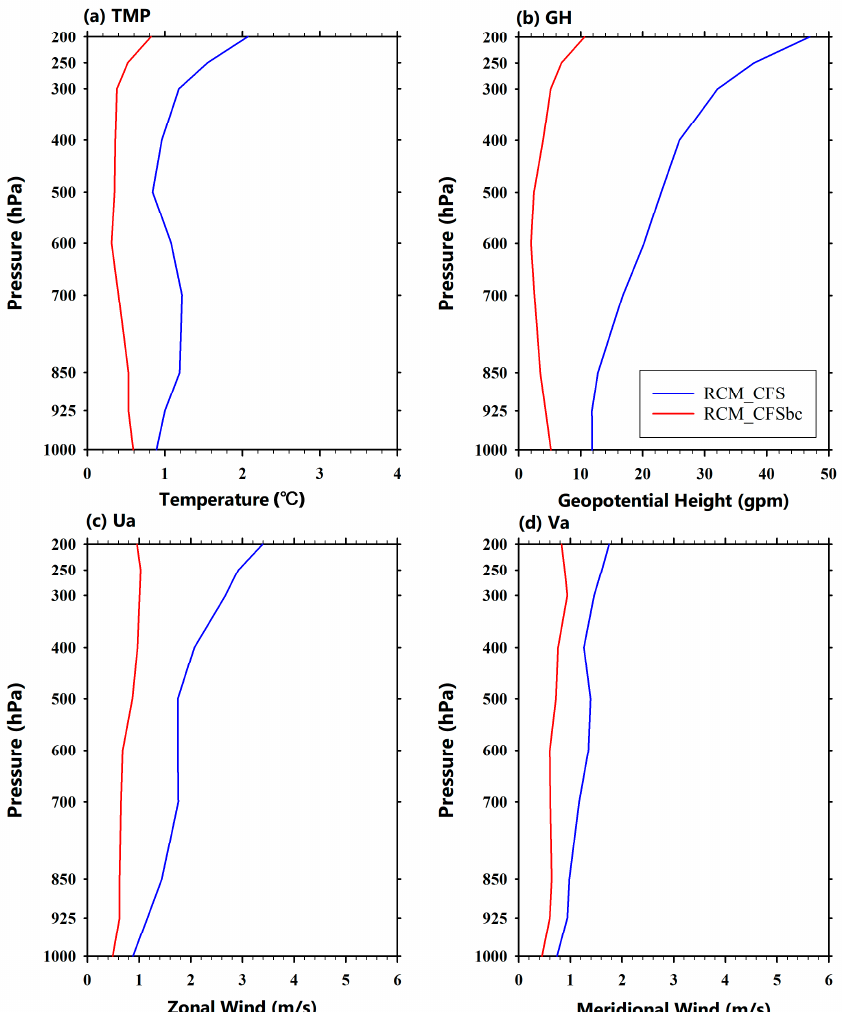
Figure 3. Root mean square difference (RMSD) between RCM_R2 and RCM_CFS (blue line), Figure3. Rootmeansquaredi ff erence(RMSD)betweenRCM_R2andRCM_CFS(blueline), RCM_CFSbc (red line) experiment for ( a ) temperature (°C), ( b ) geopotential height (gpm), ( c ) zonal wind (m / s), and RCM_CFSbc (red line) experiment for ( a ) temperature ( ℃ ), ( b ) geopotential height (gpm), ( c ) zonal ( d ) meridional wind (m / wind (m/s), and ( d ) meridional wind (m/s).